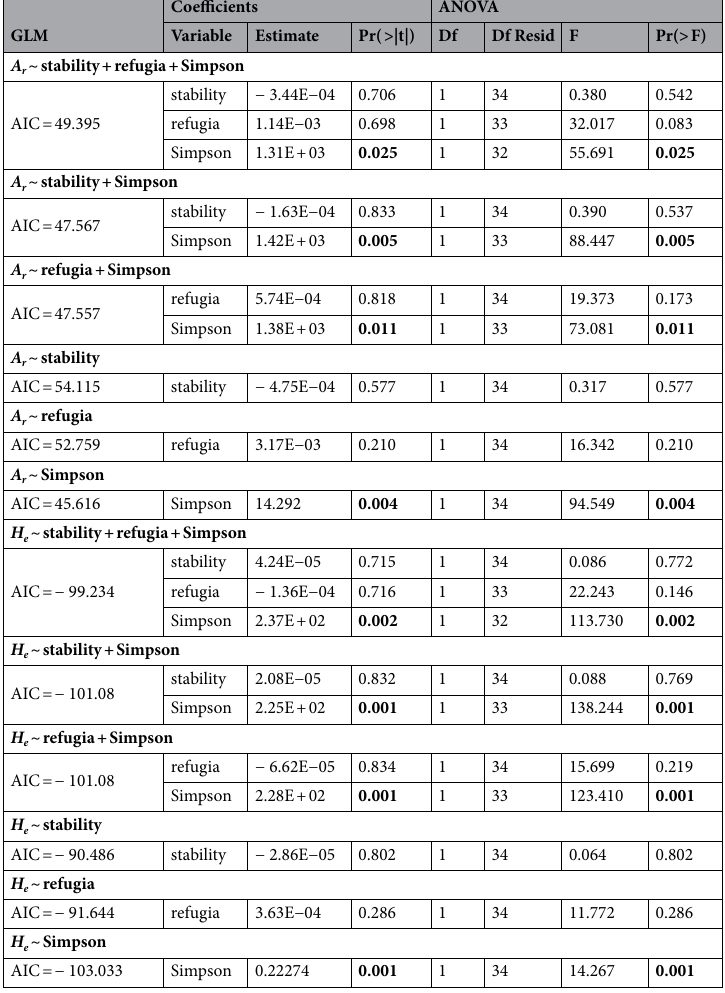
Table 2. Outcomes of the generalized linear mixed models. Allelic richness ( A r ) and expected heterozygosity ( H e ) were entered as dependent variables; distance from the nearest glacial refugium, distance from the nearest stability area, Simpson’s diversity index, and their interactions were entered as predictors. Significant factors are shown in bold. AIC, Akaike Information